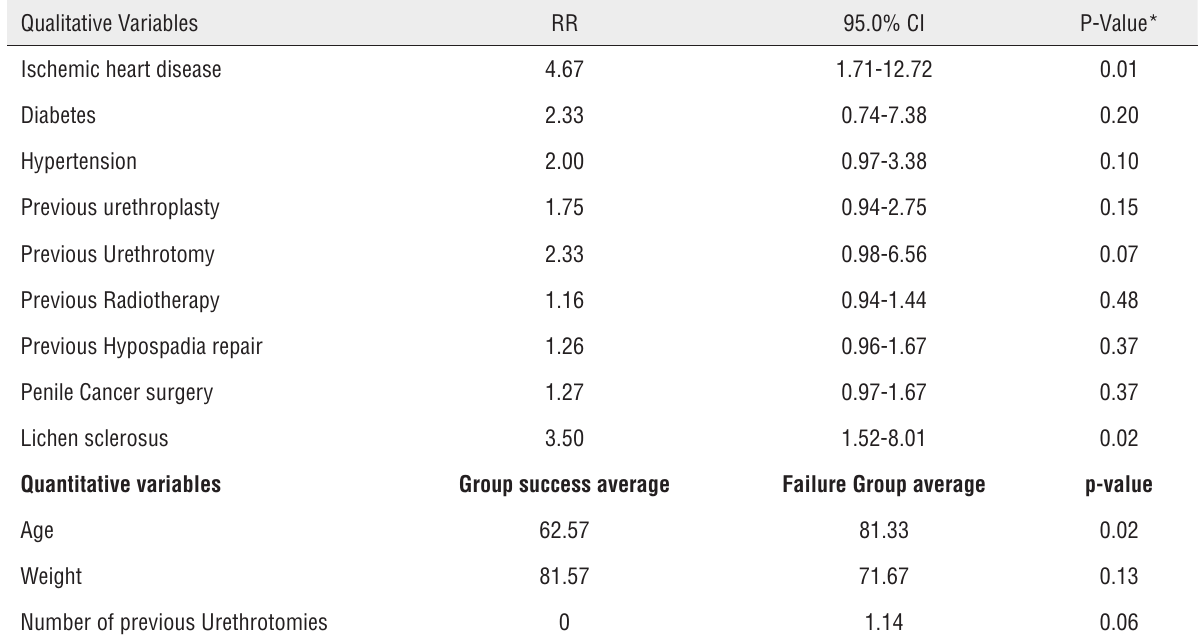
Table 1 - Variables related to procedure success. Qualitative Variables Ischemic heart disease